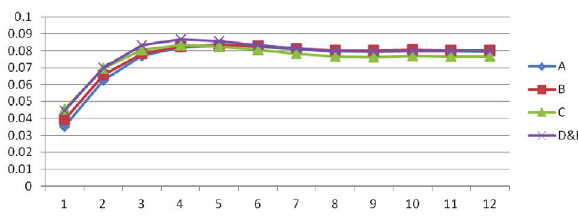
Figure 8e. Accumulated impulse response of PPI to shocks in the number of households